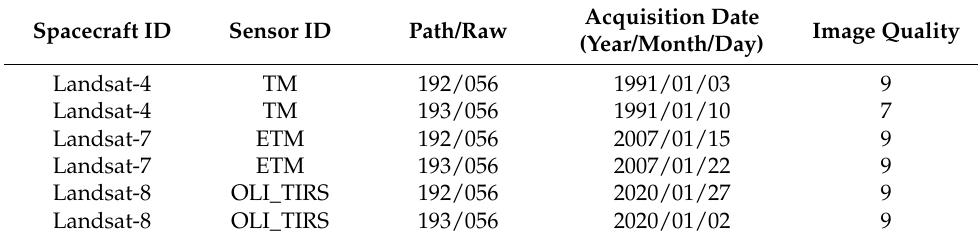
Table 1. Satellite data for LULC change.